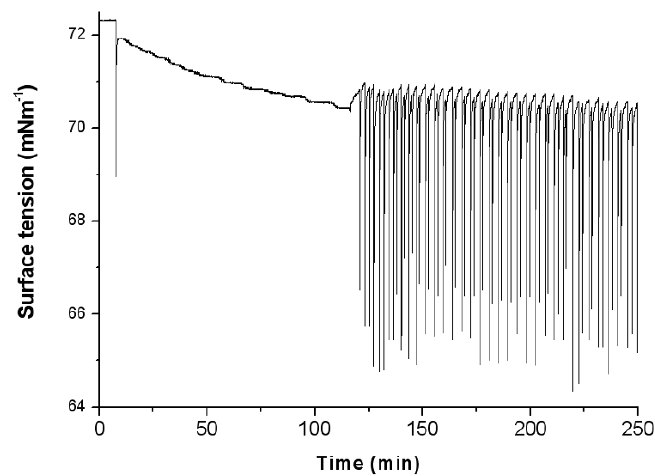
Figure 5. Combined regime produced by the dissolution of an octanoic acid droplet in 0.01 M phosphate buffer, pH=4.8. The vessel diameter d=44 mm, the capillary immersion depth h=1 mm.